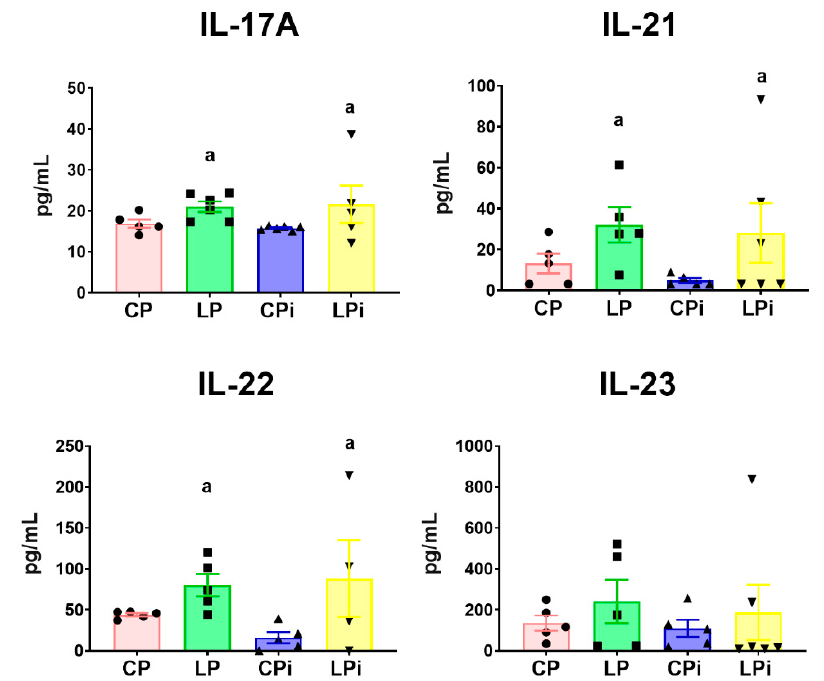
Figure 7. Protein levels of Th-17 related cytokines in the luminal fluid of duodena from malnourished BALB/c mice infected with L. infantum . IL-17A, IL-21, IL-22, and IL-23 protein levels in the luminal fluid of duodena were measured at 14 days post-infection using a flow cytometry-based multiplex assay. a: significant differences due to diet ( p < 0.05) determined by two-way ANOVA. CP: animals fed 14% protein diet; LP: animals fed 4% protein diet, CPi: animals fed 14% protein diet and infected; LPi: animals fed 4% protein diet and infected.